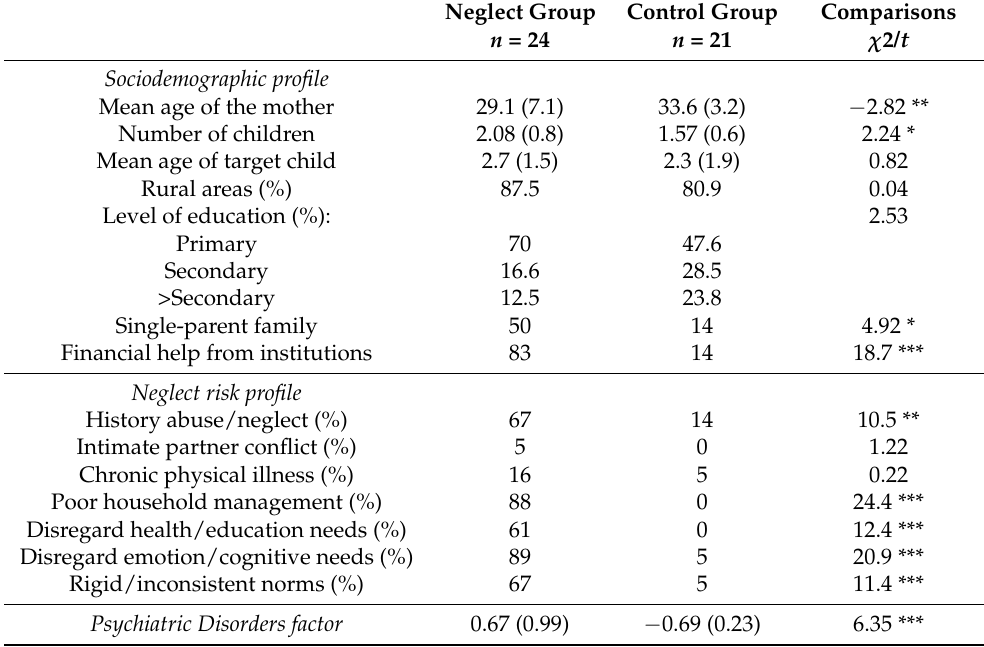
Table 1. Sociodemographic and neglect risk profile in Neglect and Control Groups. Group compar- isons with mean scores were performed with t statistic, while those with percentage values were performed with chi-square ( χ 2)